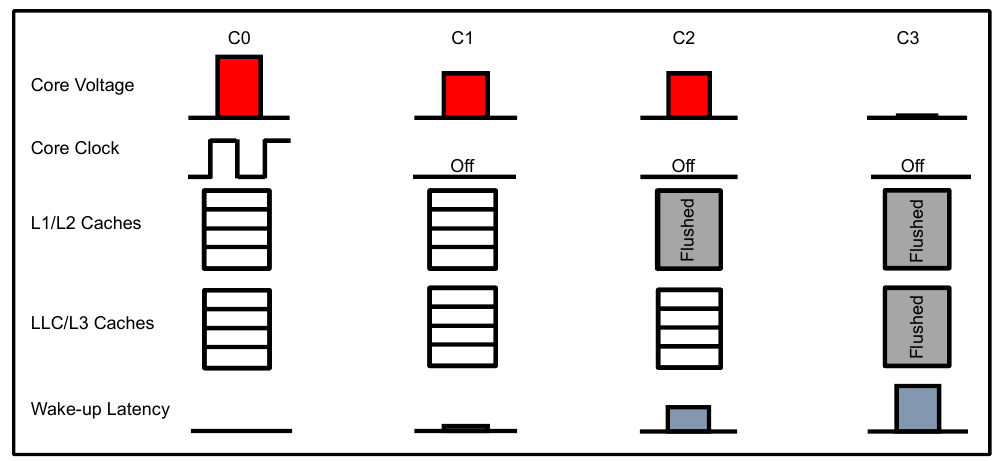
Figure 1. Core power states illustration.